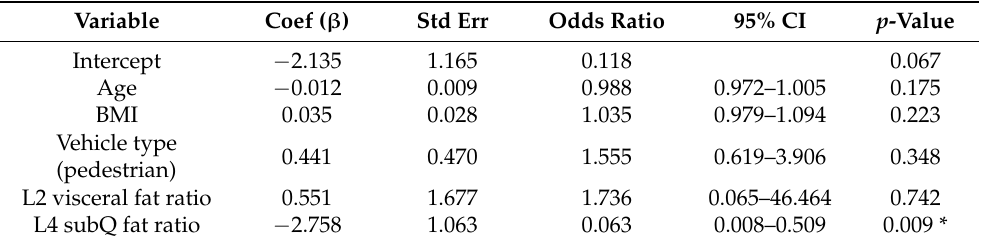
Table 3. Multivariate logistic regression of risk factors for serious abdominal injury (MAIS abd ≥